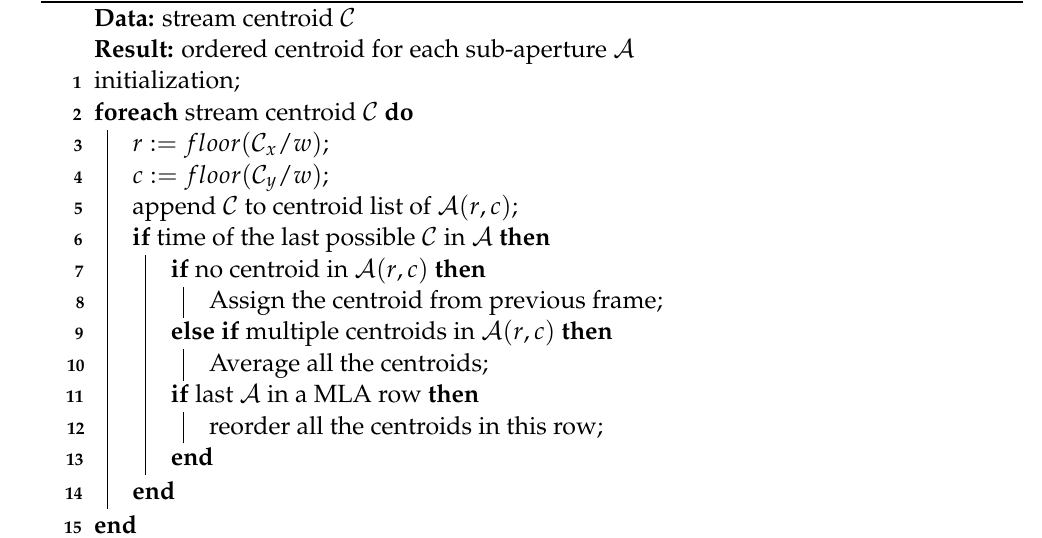
Algorithm 1: Pseudocode for sorting – processing – reordering . Data: stream centroid